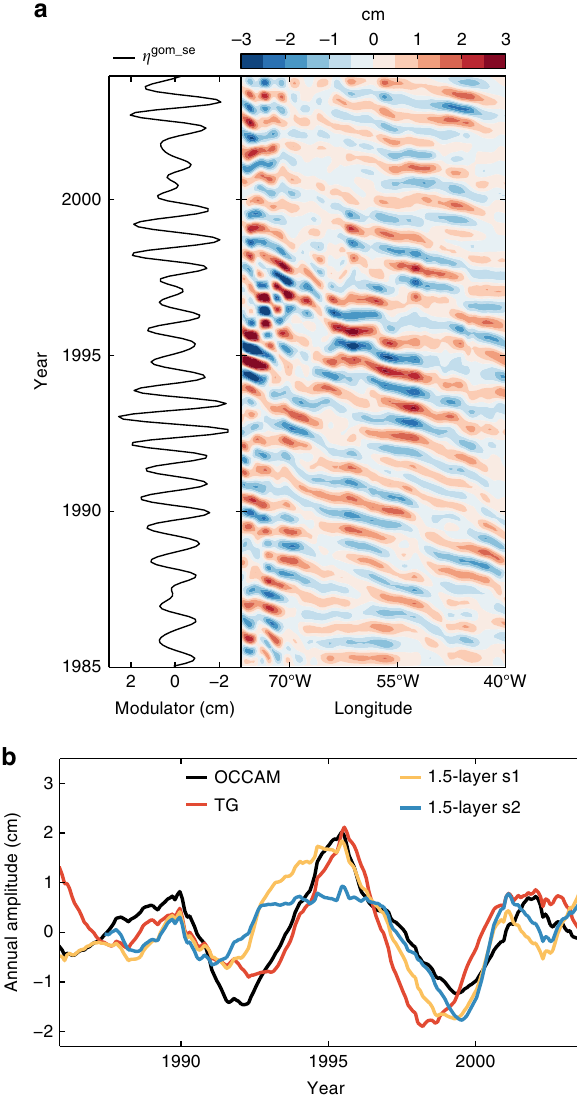
Fig. 7 Hovmöller diagram of the steric modulator and estimates from a reduced gravity model. a Time-longitude section of the steric modulator for grid points east of the Bahamas at 26.5°N in the OCCAM model. The time series of the SLAC modulator averaged along the United States Gulf and Southeast coasts ( η gom − se ) is also shown to the left. b Estimates of the SLAC amplitude at the Bahamas east coast based on a 1.5-layer, reduced gravity model for solutions one (orange) and two (blue), along with the SLAC amplitude (time mean removed) from OCCAM at the Bahamas east coast (black) and that averaged over tide-gauge stations 1 – 7